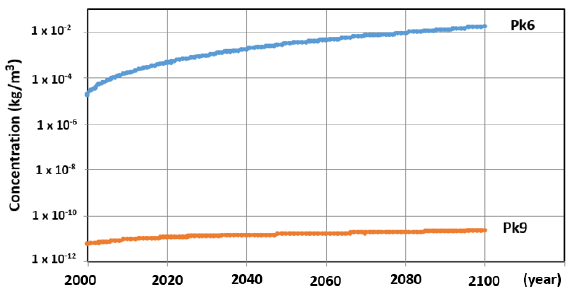
Figure A10. Concentrations variation at monitoring piezometers P1 and P6 (100 m from the coast) under RCP scenario 8.5. L1: layer 1; L9: layer 9; L18: layer 18.